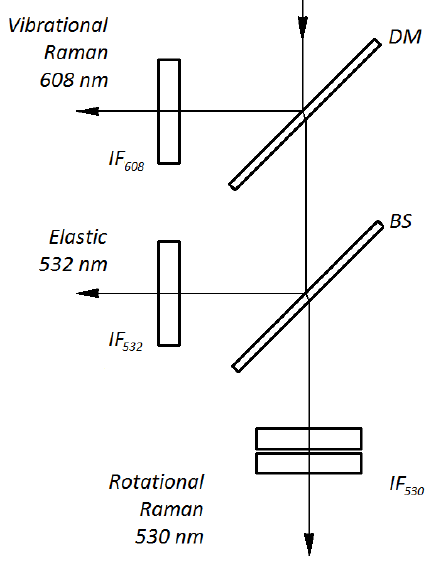
Figure 7. Optical scheme of spectral separation of Raman signals in the receiving module. DM is a dichroic 608/532nm mirror, and BS is the beam splitter reflecting about 10% at 532nm for both s and p polarizations.